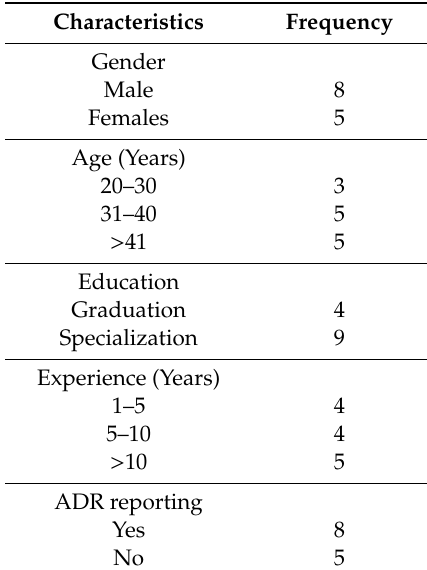
Table 3. Demographics of the